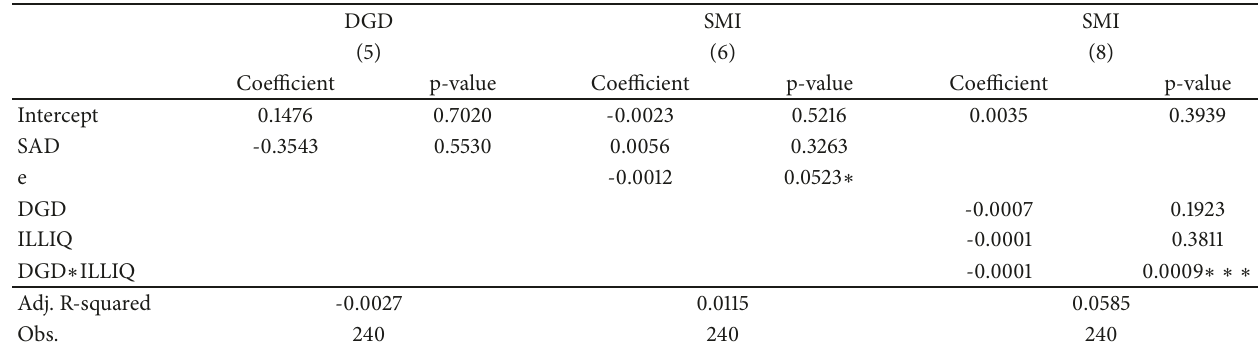
Table 7: Regression Results for Equ. (5), (6) and